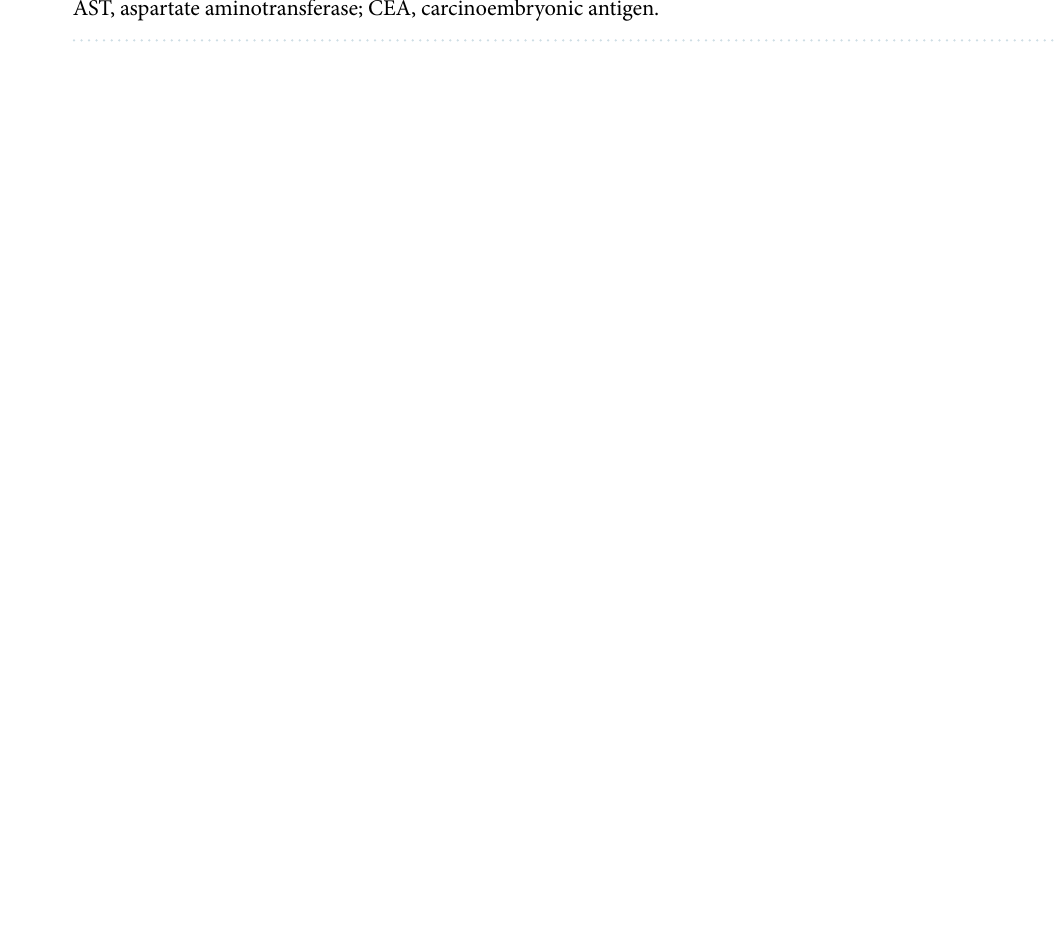
Figure 2. The nomogram for predicting the ORR of the patients after neoadjuvant TP regimen combined with PD-1 inhibitors. ORR, objective response rate; TP, taxol + platinum; PD-1, programmed cell death protein-1; AST, aspartate aminotransferase; CEA, carcinoembryonic